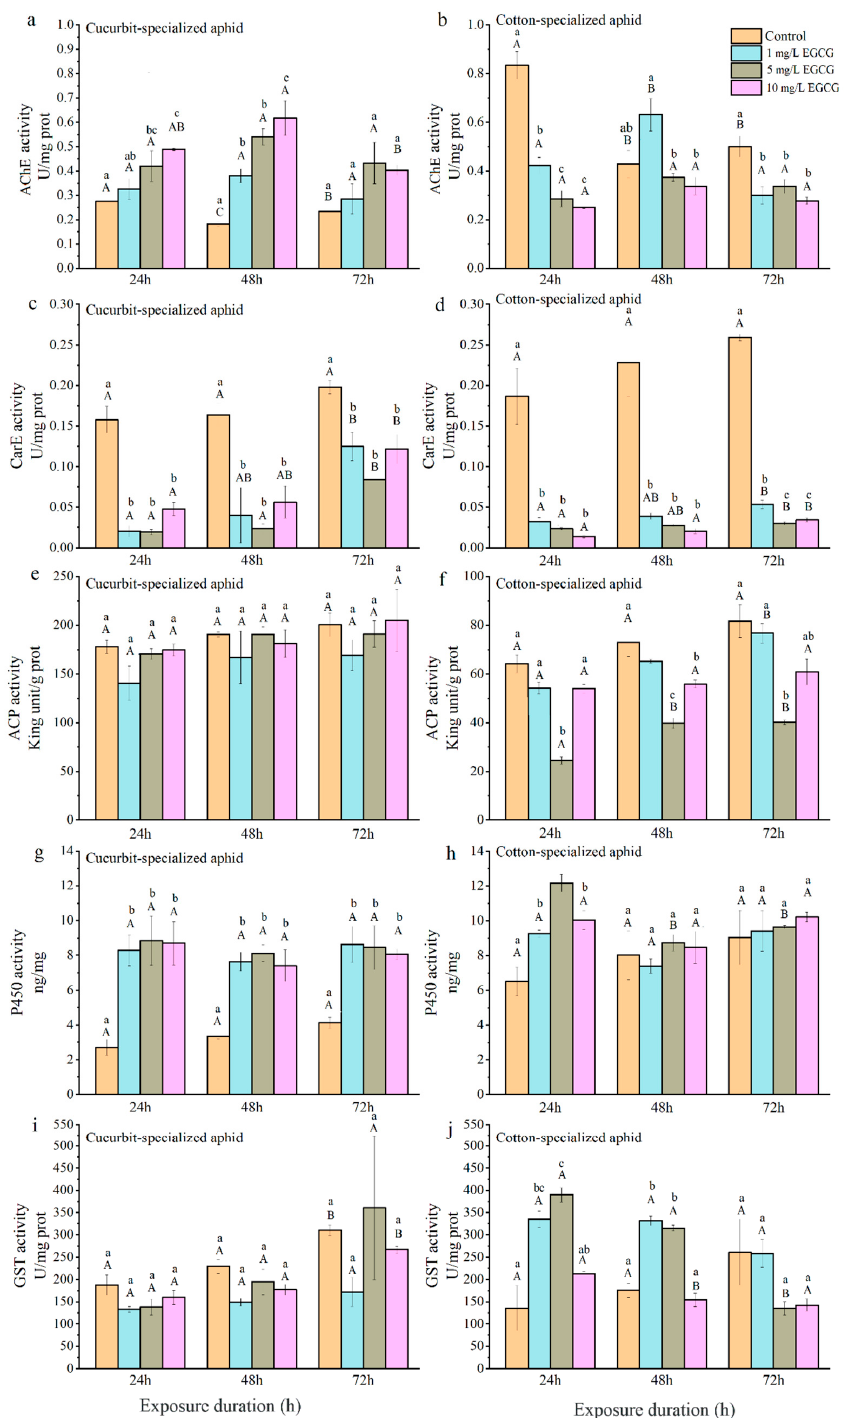
Figure 4. ( a ): AChE activity of CUS; ( b ): AChE activity of COS; ( c ): CarE activity of CUS; ( d ): CarE activity of COS; ( e ): ACP activity of CUS; ( f ): ACP activity of COS; ( g ): P450 activity of CUS; ( h ): P450 activity of COS; ( i ): GST activity of CUS; ( j ): GST activity of COS. Effect of EGCG on enzyme activity in Aphis gossypii in different time intervals.Bars labelled with different lowercase letters indicate significant differences between concentrations in same time interval, bars labelled with different capital letters indicate significant differences between time intervals in in same concentration ( p <